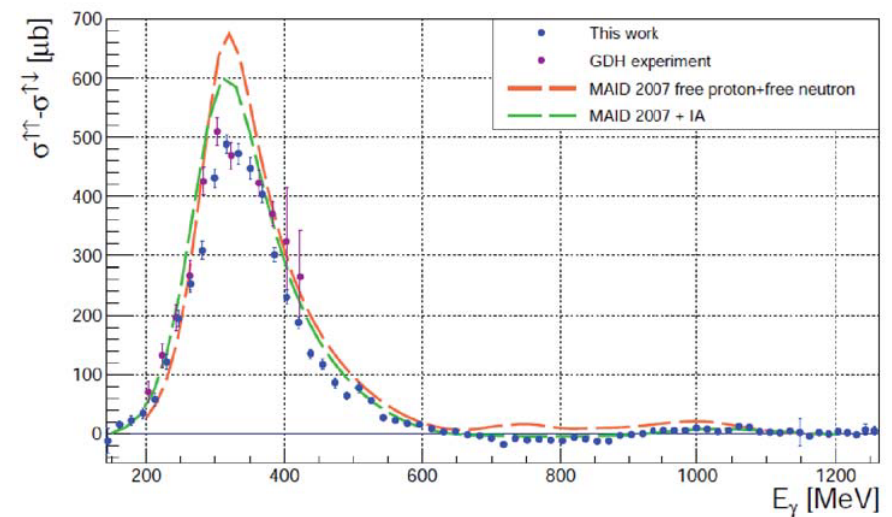
Figure 4. Helicity dependent total cross section for the semi-exclusive channel γ d → π 0 X . The A2 results (blue circles) are compared to the results from the GDH Collaboration (red circles) [13], to the MAID model (red dashed line) [14] and to the MAID model + IA correction by A. Fix based on [15] (green dashed line).